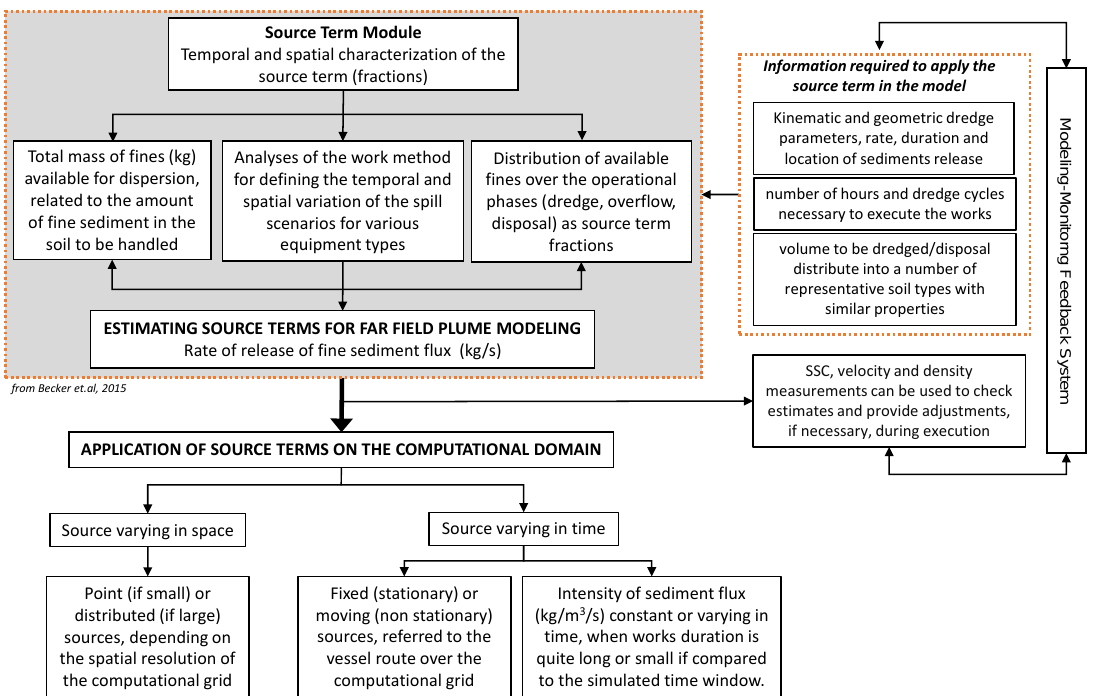
Figure 4. Main steps of the source term module for both the estimation and the application of the source term in the computational domain.